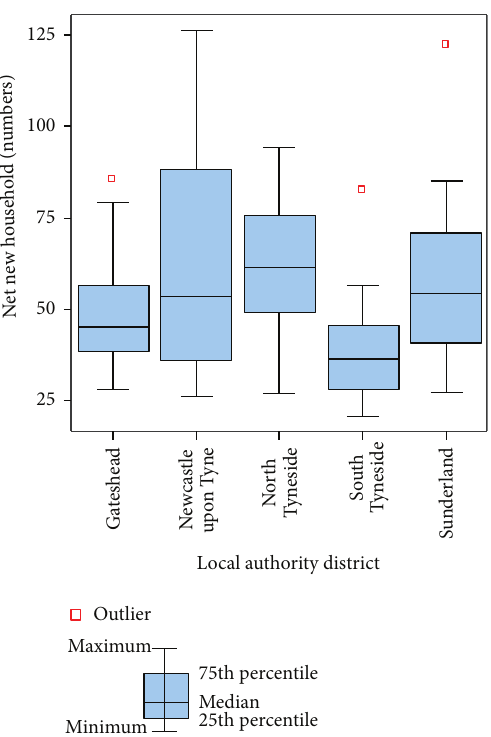
Figure 7: Aggregation of ward data on net new households: 2008– 2016, by local authority